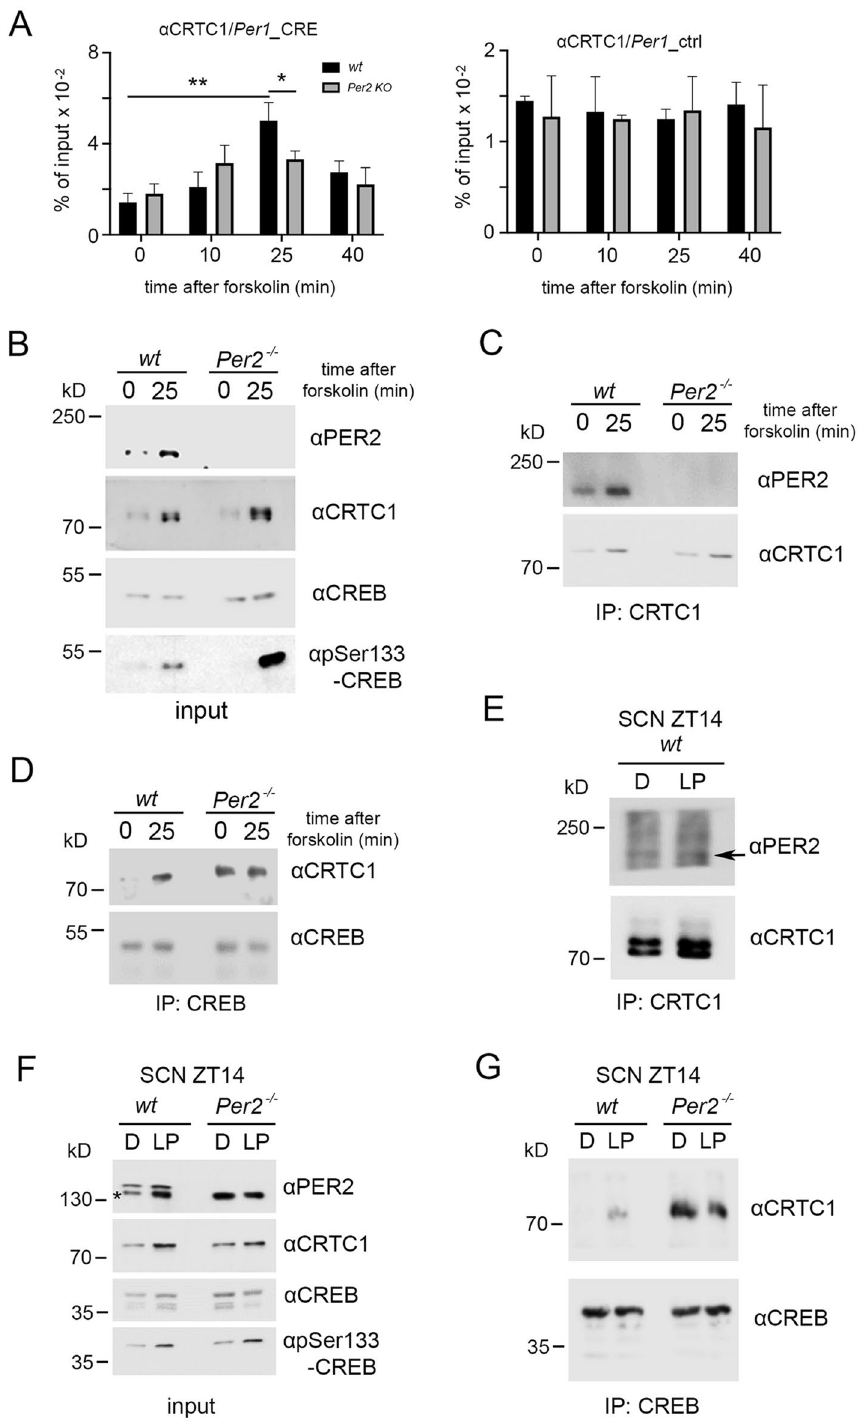
Figure 3. Binding of CRTC1 to the Per1 promoter and interaction with PER2 and CREB. ( A ) Left panel: Chromatin immunoprecipitation (ChIP) of CRTC1 on the CRE-element of the Per1 promoter in wt (black bars) and Per2 KO (grey bars) fibroblast cell lines after forskolin treatment. Right panel: Control ChIP on an unrelated promoter region of Per1. Values are the mean ± SD. Student’s t-test with Welch’s correction, n = 3, * p < 0.05, ** p < 0.01. Two-way ANOVA indicates a significantly different time profile between the two genotypes, ** p < 0.01. ( B ) Western blot of wt and Per2 -/- ( Per2 KO) cells before and 25 min after forskolin treatment. CRTC1 is induced by forskolin independently of Per2 . CREB is phosphorylated (pSer133) in both genotypes after the stimulus. ( C ) Immunoprecipitation (IP) of CRTC1 pulls down PER2 independently of forskolin treatment. ( D ) IP of CREB pulls down CRTC1 after forskolin treatment in wt cells, but in Per2 -/- cells, the interaction between CREB and CRTC1 is forskolin independent. ( E ) IP of CRTC1 in SCN extracts before and after a 15 min light pulse (LP) at ZT14. Co-IP of PER2 is independent of LP. ( F ) Western blot of wt and Per2 -/- SCN tissue performed as in B on samples collected before and after LP, * unspecific band recognized by the αPER2 antibody in tissue extracts. CREB is phosphorylated in both genotypes after the light pulse. ( G ) IP of CREB pulls down CRTC1 in wt SCN extracts after LP, but in Per2 -/- SCN the CREB: CRTC1 interaction is light-independent. kD = kilo